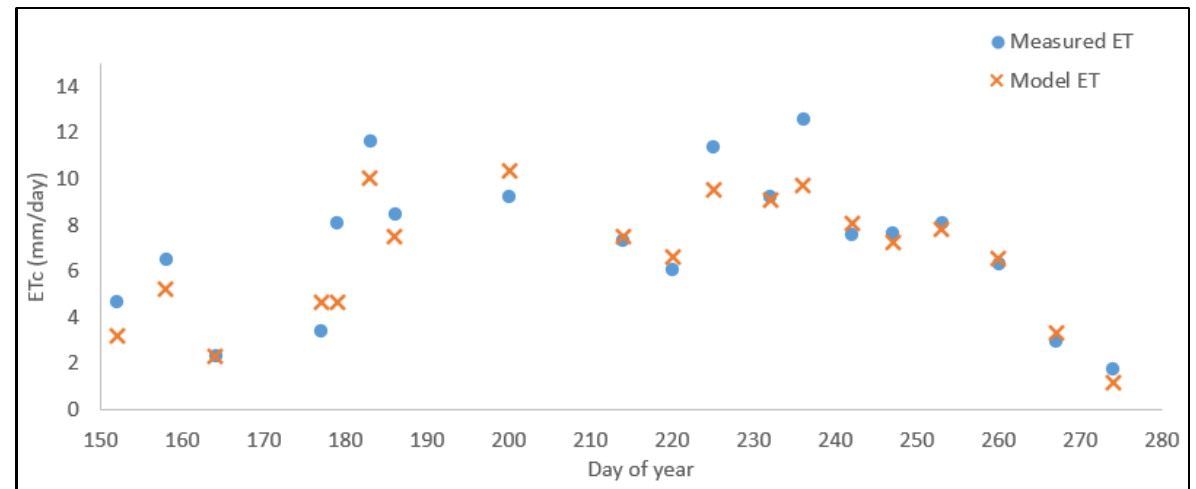
Maricopa, Arizona.